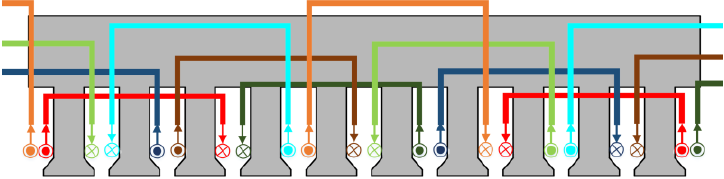
Figure 4. Winding pattern for N P = 6, N S = 21 (q = ½ ).